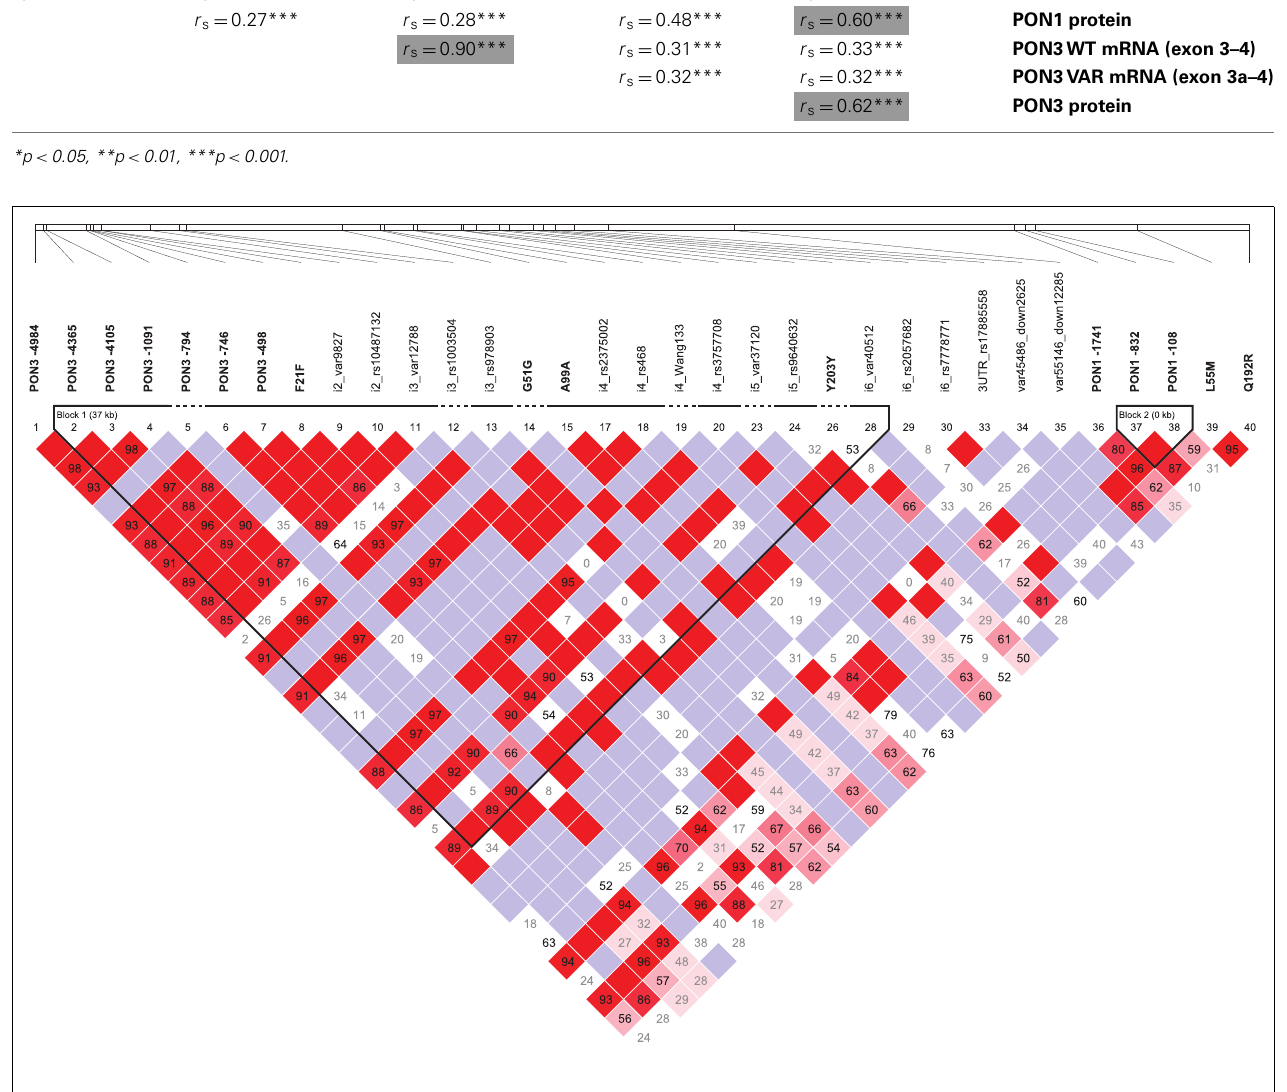
FIGURE 3 | Pairwise linkage disequilibrium is shown for the 40 polymorphisms genotyped in this study. The map was generated using Haploview 4.2. Numbers represent D (cid:2) values. D (cid:2) = 1: bright red (LOD > 2) or blue (LOD < 2); D (cid:2) < 1: shades of pink (LOD > 2) or white (LOD < 2).